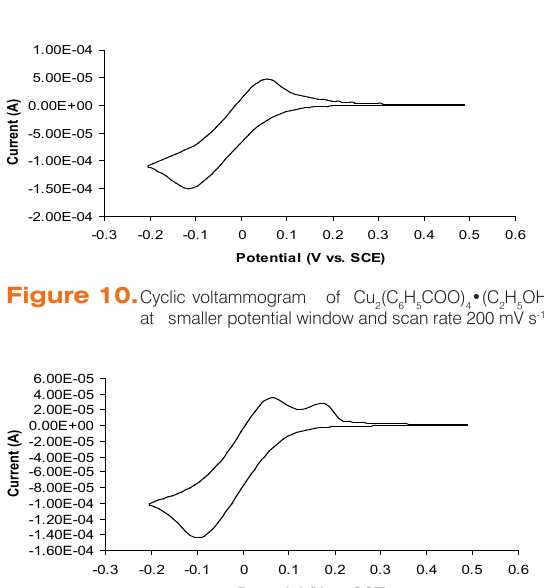
Figure 9. Dependence of the currents on the square root of the scan